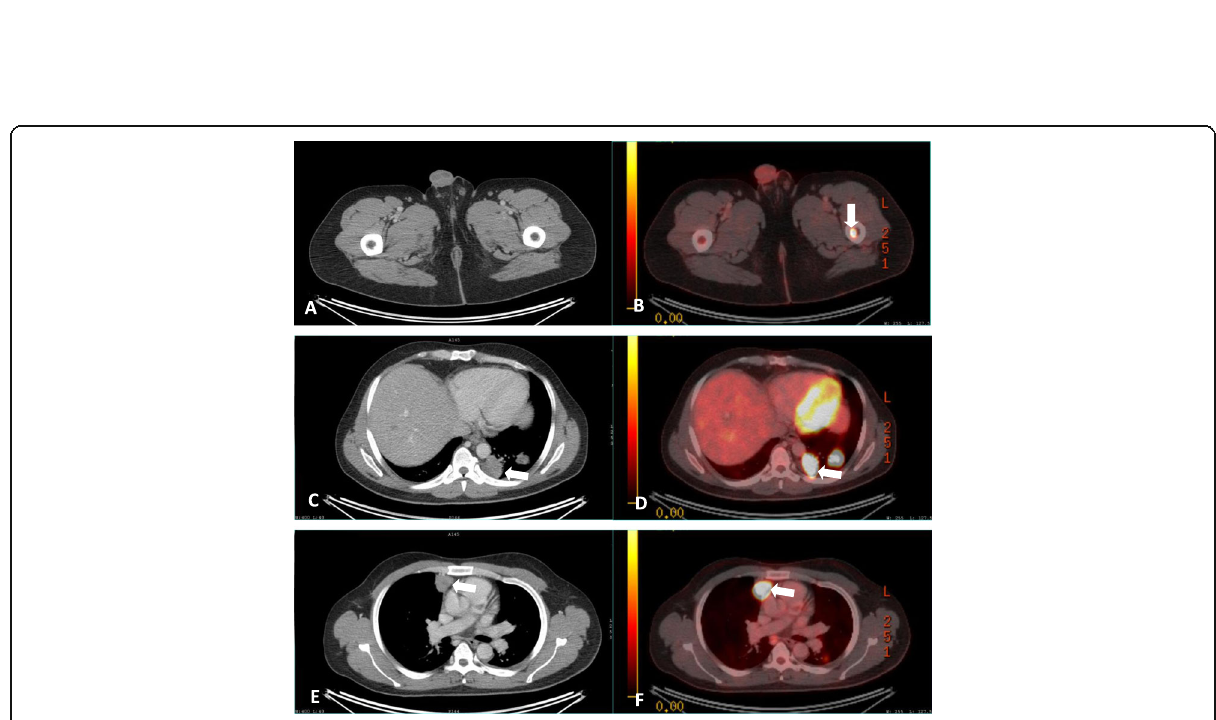
Fig. 3 Thirty-one-year-old male patient with history of NHL received CTH. Multiple variable-sized marrow infiltrative lesions largest seen at left femur ( a and b ) with Max SUV of 25. Bilateral multiple variable-sized metabolically active nodules are seen involving lung parenchyma ( c – f ) in which the largest on the right side seen involving the right medial segment of middle lobe measuring 30 × 27 mm and SUV max = 302, and on the left side, the largest nodule is seen at postero-medial segment of lower lobe measuring 25 × 29 mm. SUV max = 24, consistent with a score of 5 on the five-point scale